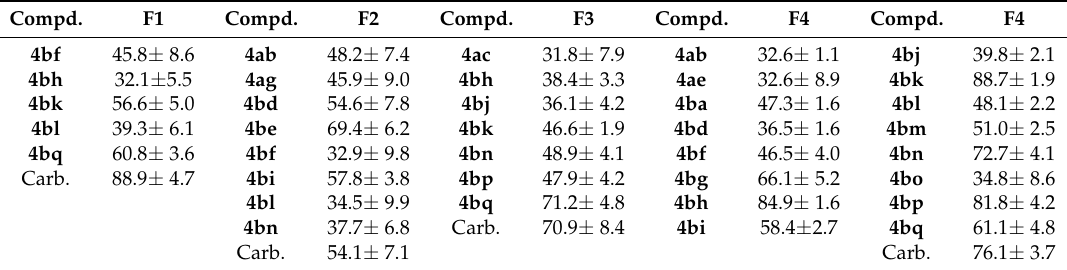
Table 3. Antifungal activities of target compounds (%, 100